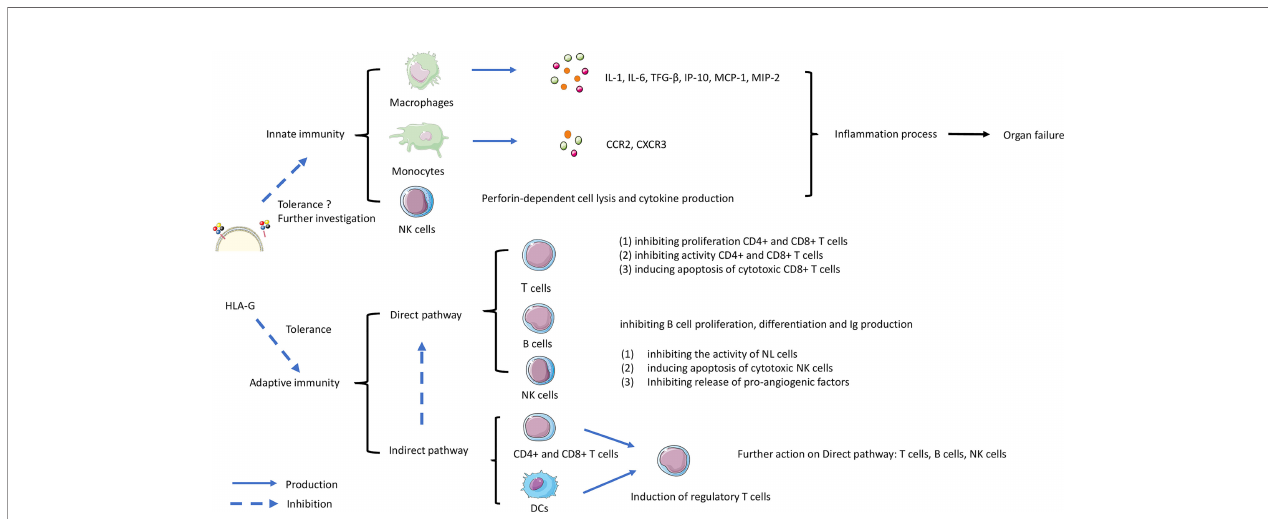
FIGURE 3 | The role of HLA-G in controlling rejection in organ transplantation. The complex process involves both innate and adaptive immunity. HLA-G interaction on macrophages, monocytes, and NK cells can trigger the production of cytokines leading the in fl ammation contributes to rejection. Another interaction work on adaptive immunity involved direct and indirect pathways. The direct pathway is HLA-G directly inhibiting immune effectors such as T cells, B cells, and Natural Killer (NK) cells. The indirect pathway involves HLA-G acting on dendritic cells (DC) and CD8+/CD4+ T cells. Subsequently acting on T regulatory cell (T reg) formation, then continue acting on the direct pathway with inhibiting the functional